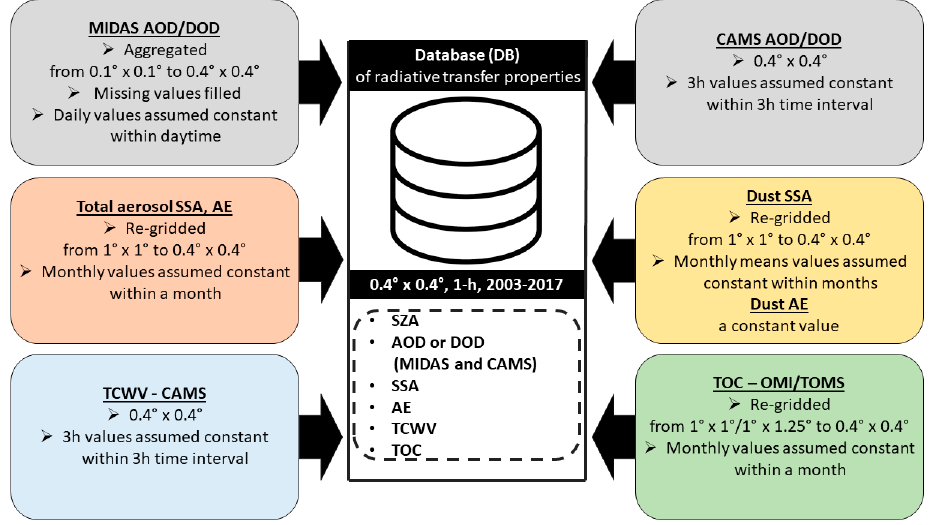
Figure 1. Schematic overview of the database (DB) created for the RTM simulations, on a 0.4° × 0.4° lon/lat grid and 1h temporal resolution.